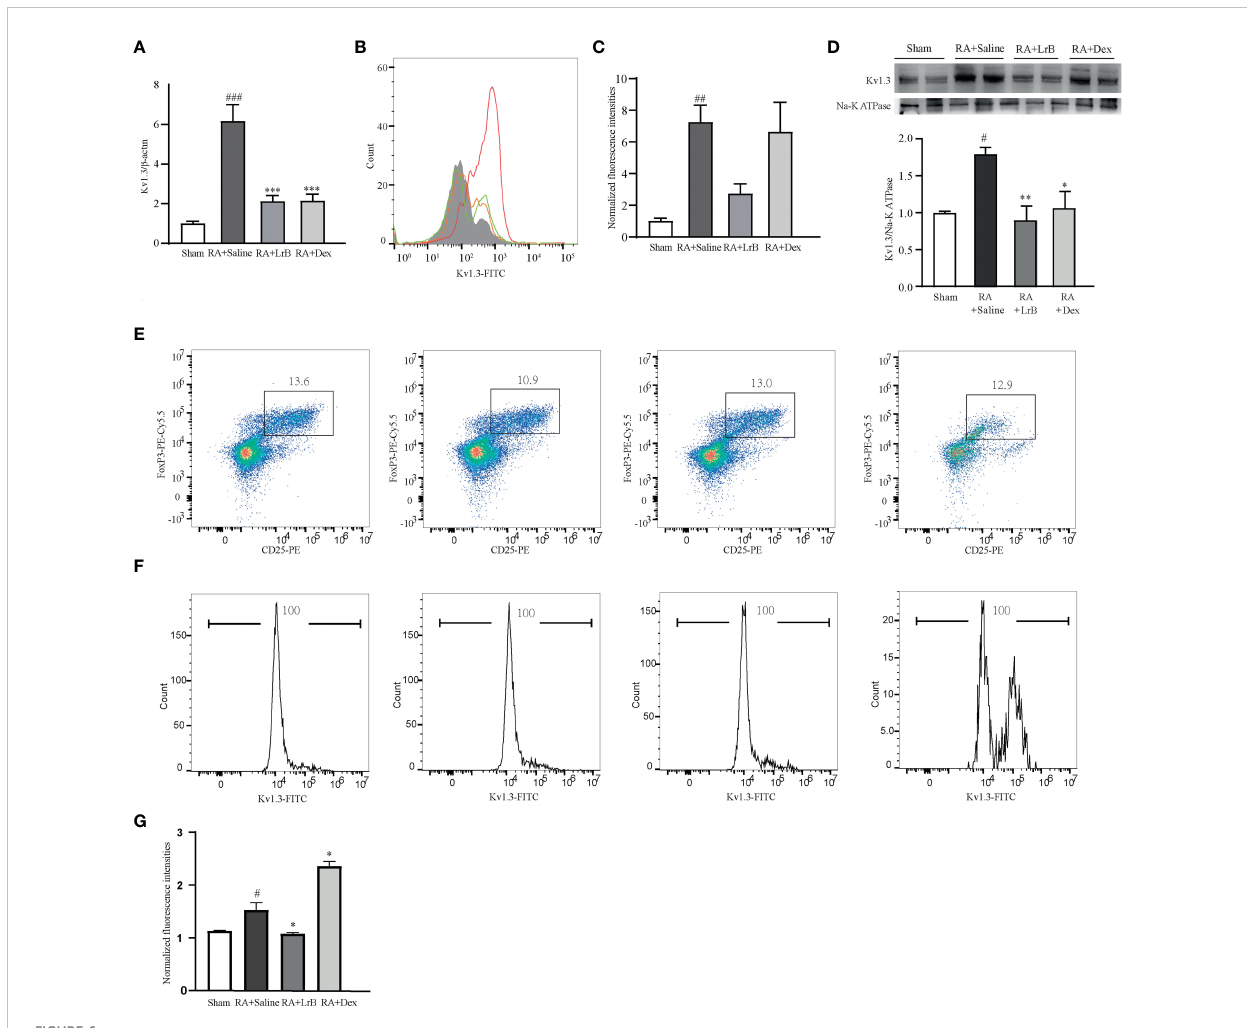
FIGURE 6 LrB decreased Kv1.3 expression in PBMCs and Treg cells in spleen. (A) Kv1.3 mRNA in PBMCs as shown by qPCR (n = 5). (B, C) The fl ow cytometry histogram (B) and average fl uorescence intensity values (C) of Kv1.3 channel protein expressed on the membrane of PBMCs (n=4). (D) Kv1.3 expression was analyzed by western blot (n = 4). (E) Scatter diagram of CD25+FoxP3+ regulatory T-cell subtype (Treg cells) in CD4+ spleen cells of Sham and CIA rats with different treatments. (F) The fl ow cytometry histogram of Kv1.3-FITC fl uorescence of Treg cells. (G) The statistics of FITC fl uorescence of Treg cells (n=3). (Results are expressed as the mean ± SEM, and tested with One Way ANOVA. #, P ≤ 0.05, ##, P ≤ 0.01, compared to the Control group, * P ≤ 0.05, P ≤ 0.01, compared to the PHA stimulus